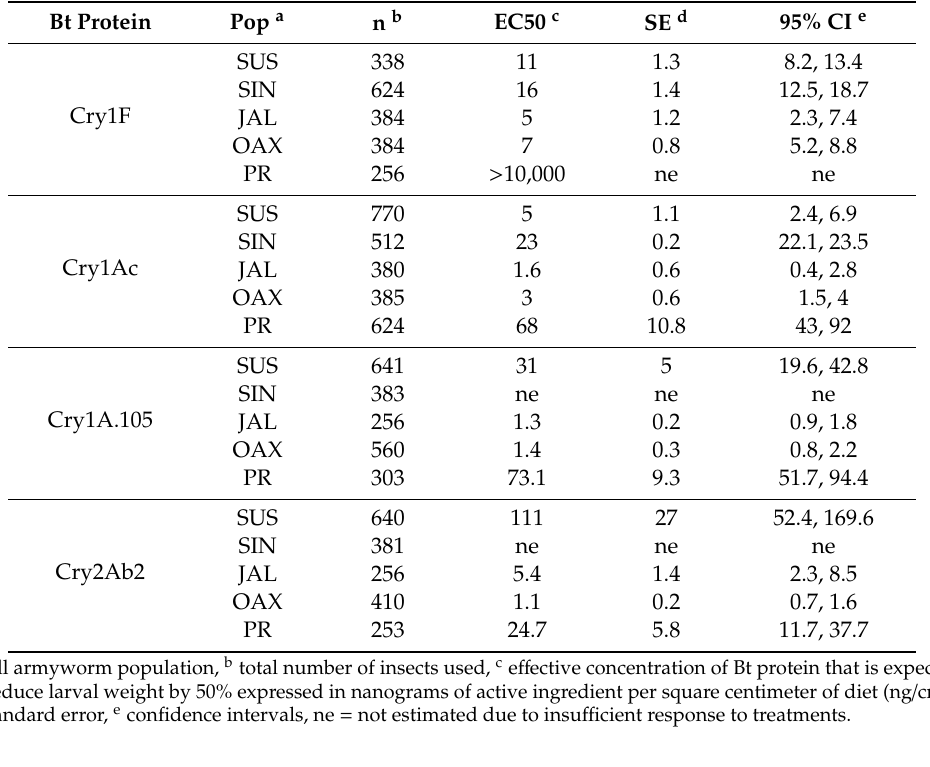
Table 3. E ff ective concentration of Bt proteins that is expected to reduce weight by 50% (ng / cm 2 ) in fall armyworm from several Mexican states and Puerto Rico.